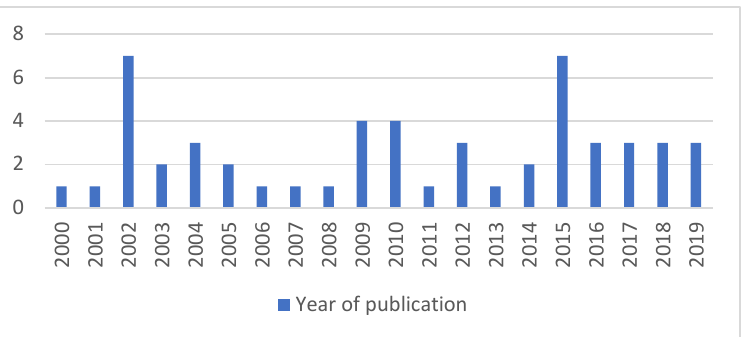
Figure 3. Number of papers published on uncertainty in refurbishment and project management over the reporting period.